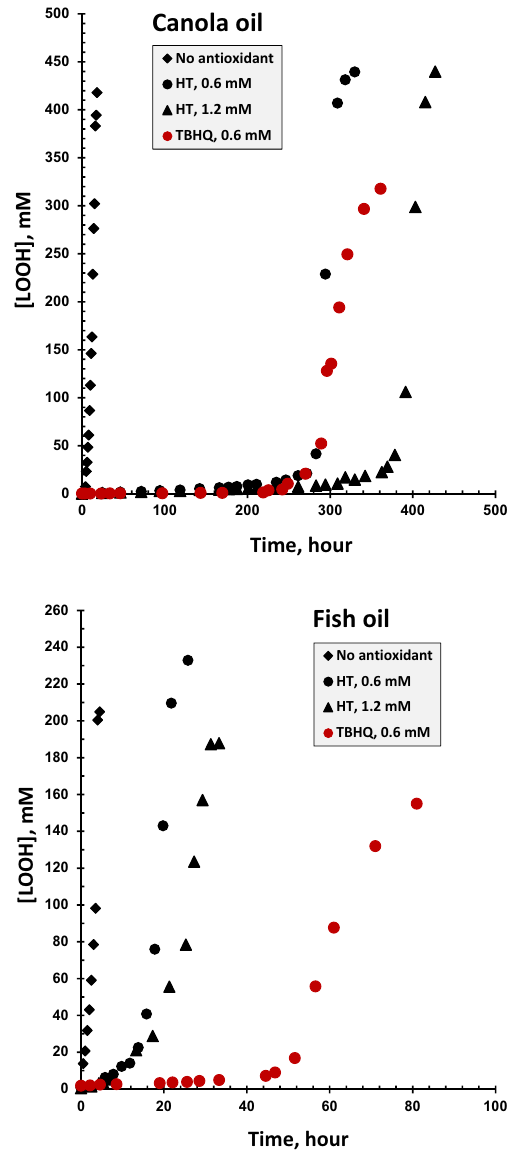
Figure 3. Kinetic curves of the accumulation of lipid hydroperoxides (LOOH) during the non-inhibited and inhibited (hydroxytyrosol, HT, and tert -butylhydroquinone, TBHQ) peroxidations of the oil samples at 60